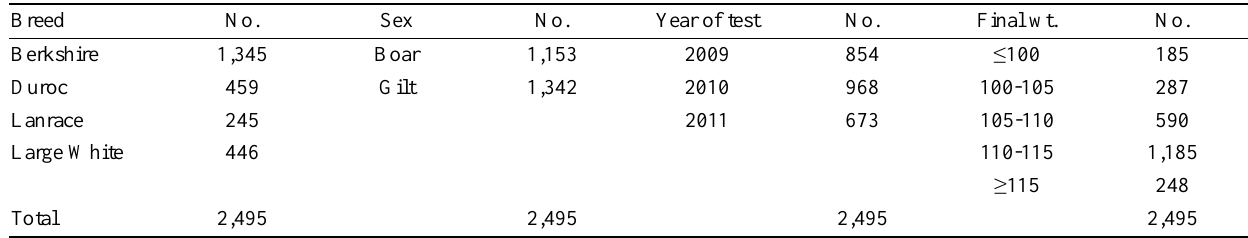
Table 1. Number of animals by breed, sex, year of test and final weight of test animal Breed